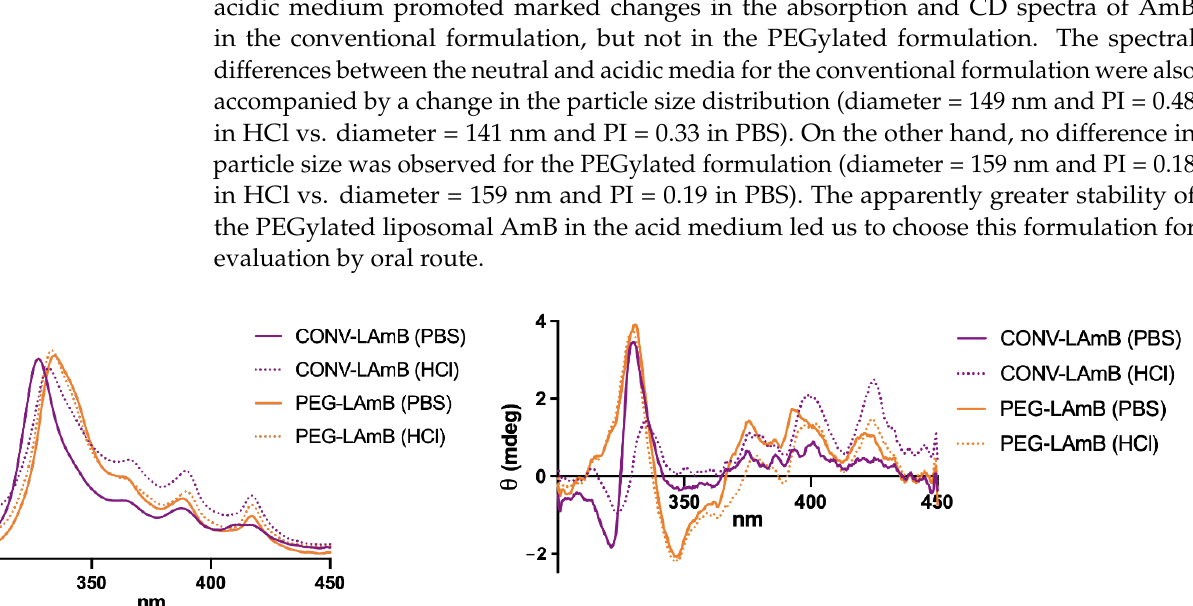
Figure 3. Circular dichroism spectra of AmB in the presence of pre-formed ( a ) PEGylated or ( b ) conventional liposomes, before and after heating at 60 °C, as second step of the process of incorpo- ration of AmB.